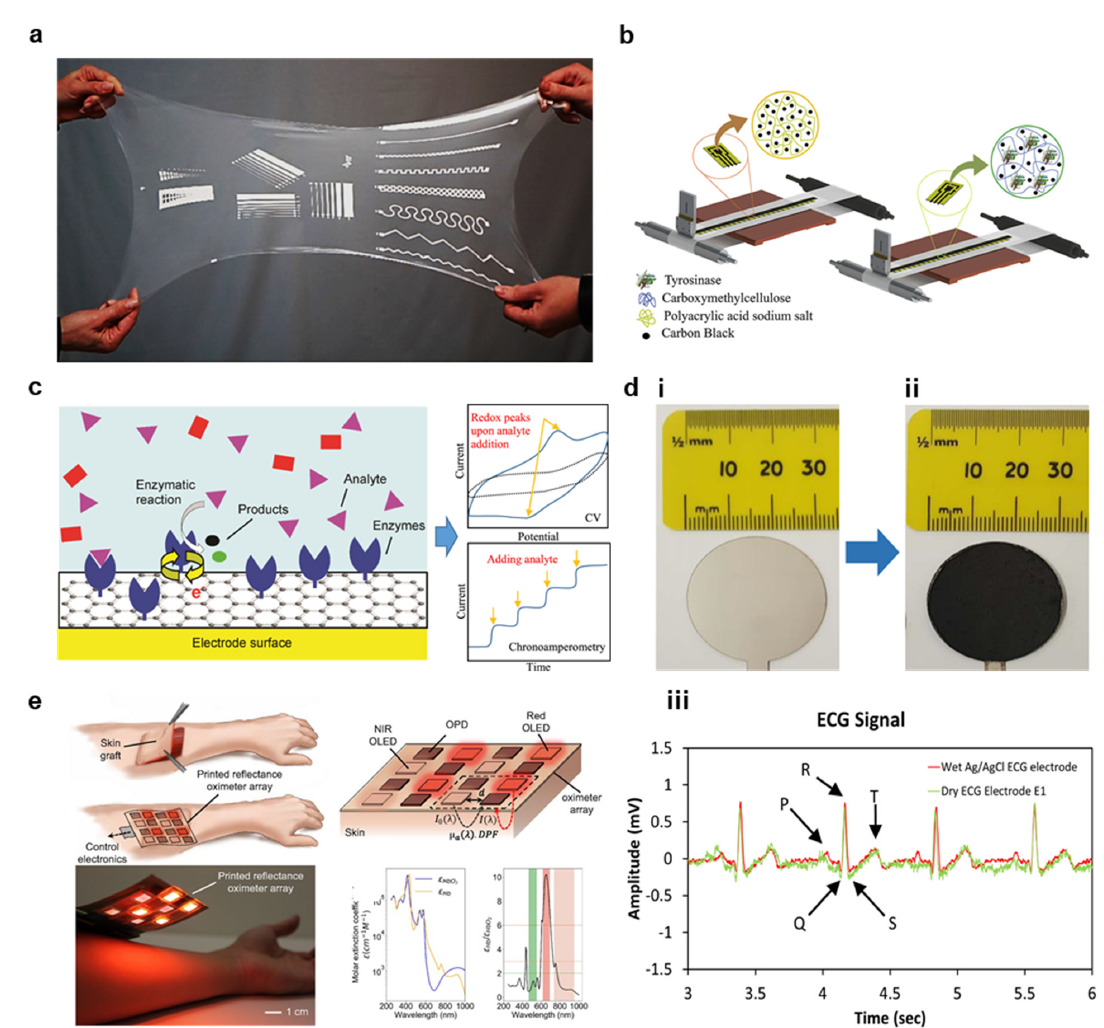
Figure 10. Bioelectronics applications ( a ) Image of screen-printed conductive traces. (reprinted with permission from Ind. Eng. Chem. Res . (2019), 58, 43, 19909–19916, Copyright 2020, ACS). ( b ) Illustration of roll-to-roll slot-die coated electrochemical sensors. (reprinted with permission from Biosens. Bioelectron. (2020), 165, 112428. Copyright 2020 Elsevier). ( c ) Schematic of a graphene-based enzymatic biosensor. (reprinted with permission from Biosens. Bioelectron. (2017), 87, 7–17. Copyright 2017 Elsevier). ( d ) Screen-printed ECG electrodes with ( i ) Ag and ( ii ) MWCNT layers. ( iii ) Example ECG signals are shown compared to commercial Ag/AgCl gel electrodes. (reprinted with permission under Creative Commons license CC BY-NC-ND 4.0 from Sens Biosensing Res (2018), 20, 9–15.) ( e ) Overview and operation of a screen-printed reflectance oximeter array (ROA). ( Top left ) placement of the ROA after skin graft surgery. ( Top right ) illustration of ROA pixel array. ( Bottom left ) Image of the printed ROA. ( Bottom right ) Molar extinction coefficients for oxygenated and deoxygen- ated hemoglobin as a function of wavelength. (reprinted with permission from PNAS , (2018) 115 (47) E11015–E11024, Copyright 2018, PNAS).